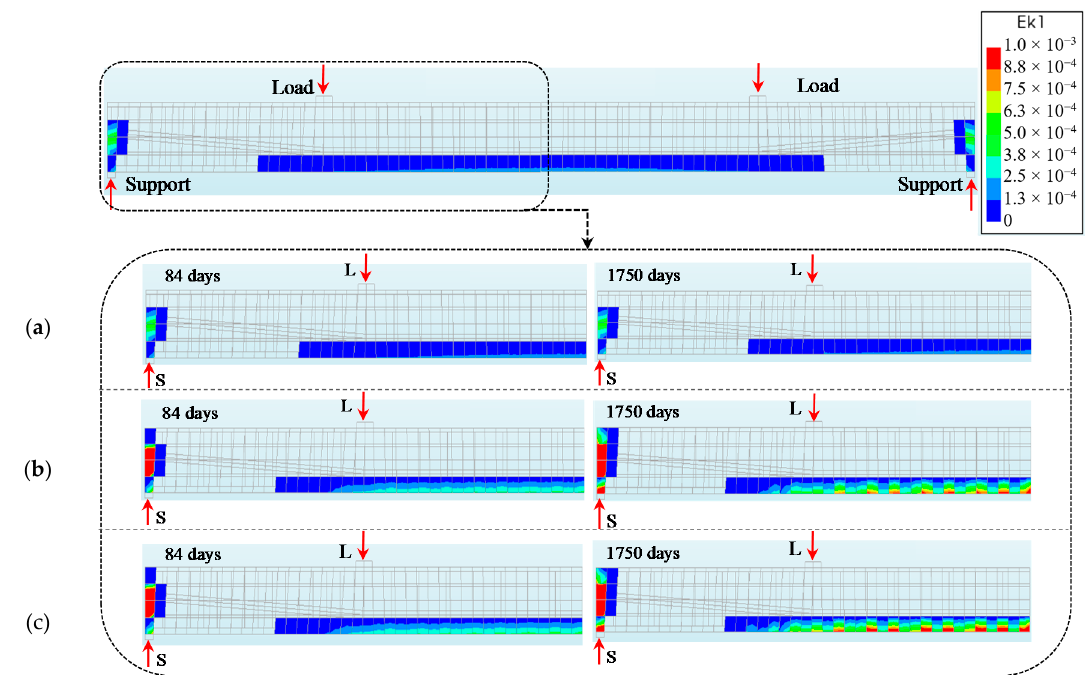
Figure 8. Distribution of crack strain of the short-span PSC beam at 84th and 1750th days. ( a ) Cracking only ; ( b ) C&US+Cracking ; ( c ) C&US+NUS+Cracking.